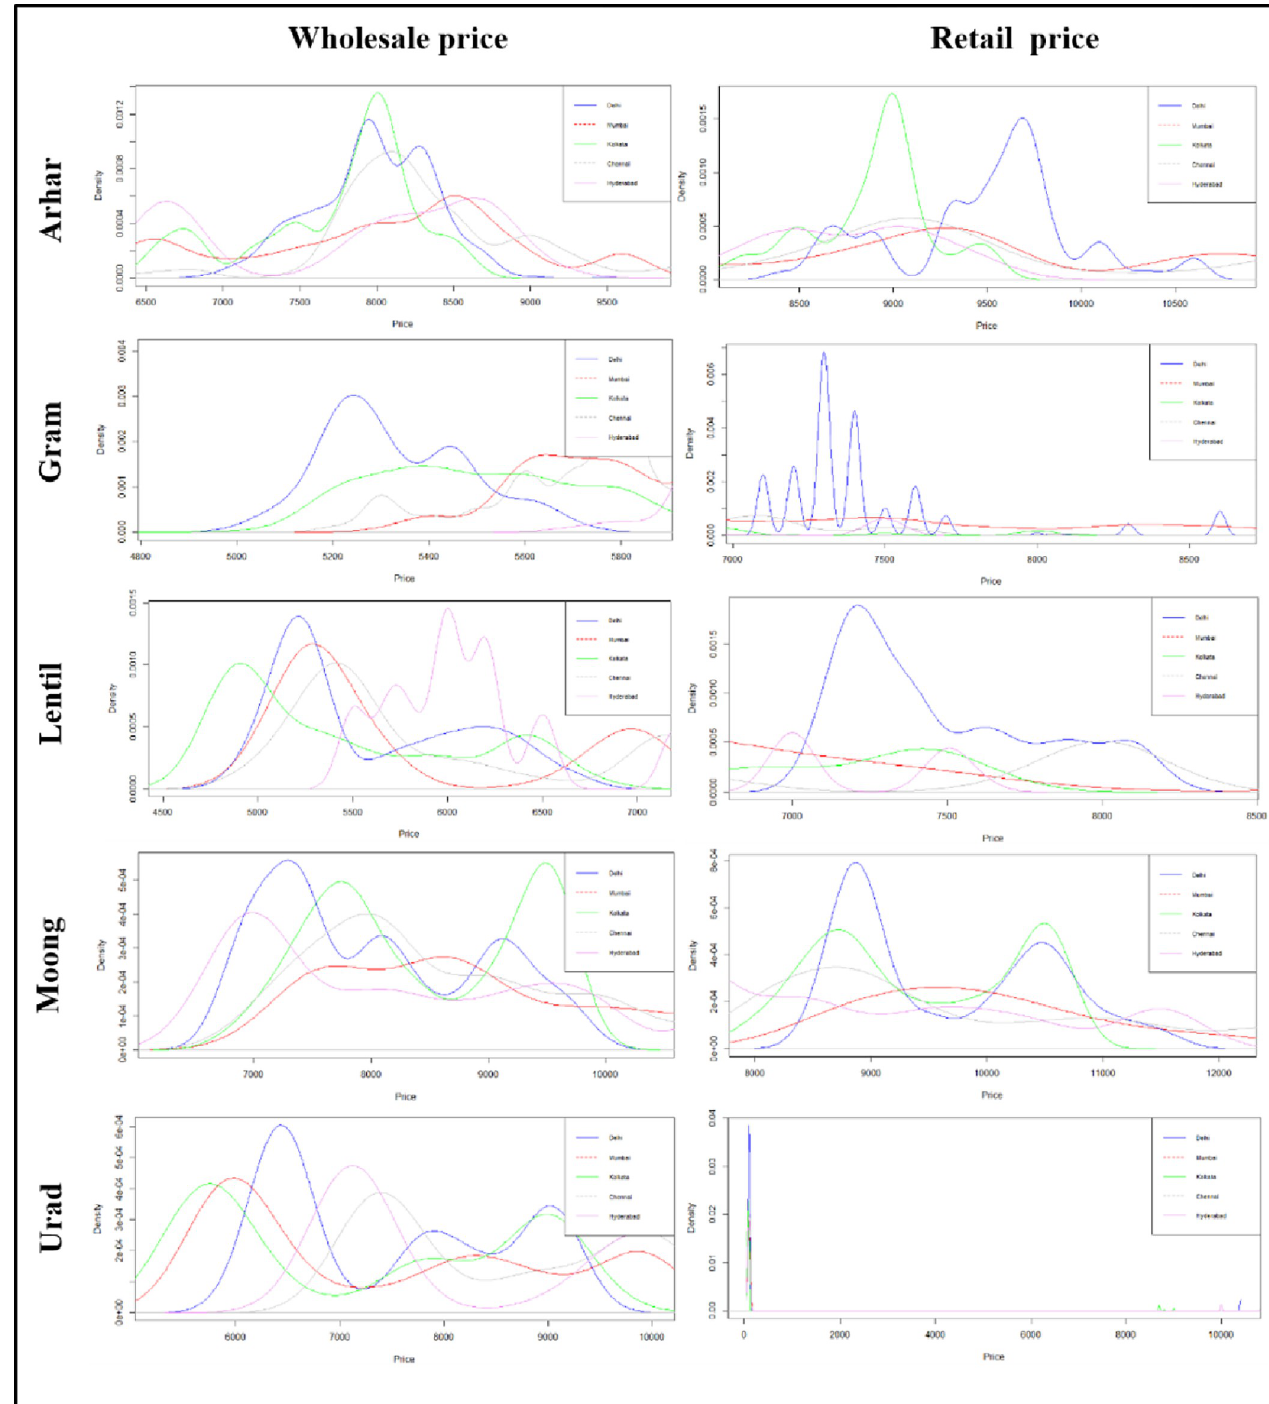
Fig 4. Kernel density estimate of wholesale and retail prices of pulses in different markets.